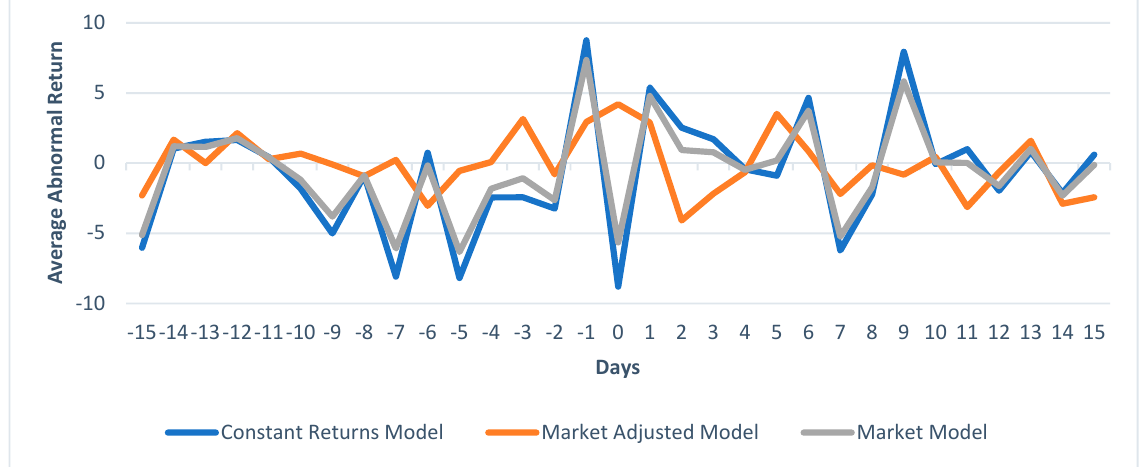
Figure 6. Event period AAR for the IT sector (source: the authors). Apart from these sectors, the automobile sector also faced adverse impacts.